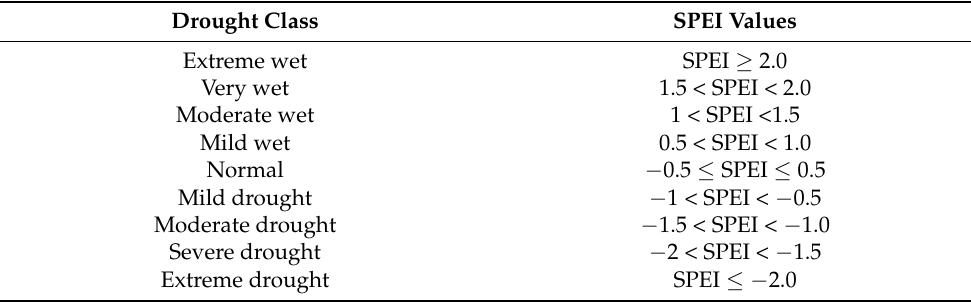
Table 1. Classification used for Standardized Precipitation Evapotranspiration Index (SPEI).